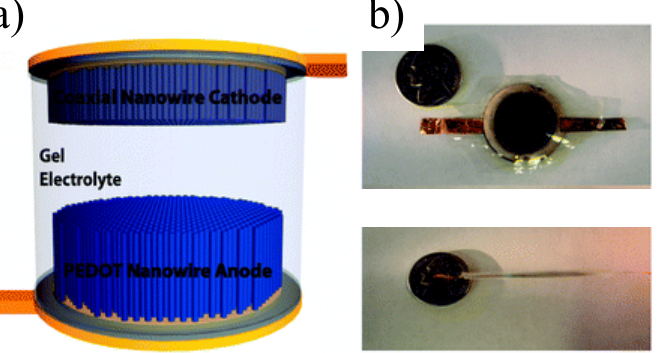
Figure 13. ( a ) Side-view schematic of the asymmetric device, where gray represents the coaxial MnO 2 /PEDOT nanowire cathode and blue represents the PEDOT nanowire anode ( b ) Picture of the same demo device [150]. Copyright 2012. Reproduced with permission from the publisher: RSC.